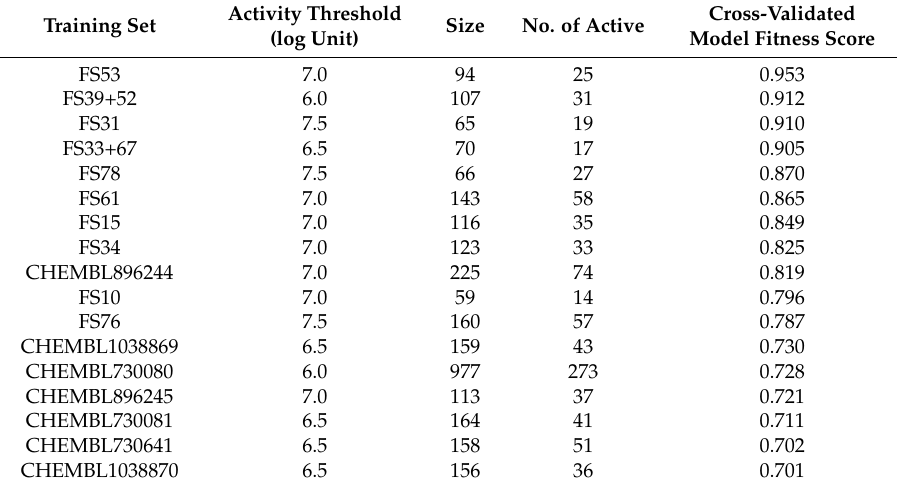
Table 3. SVM classification consensus model